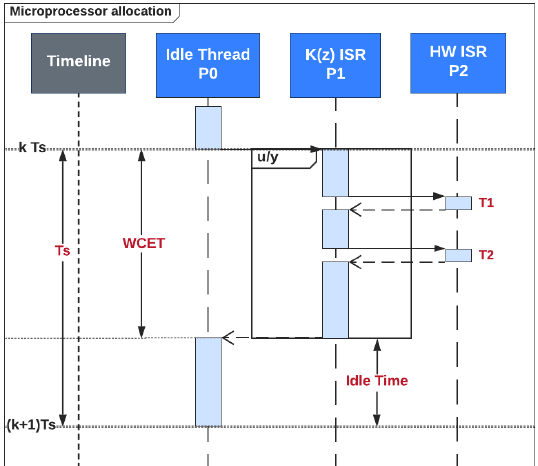
Figure 4. Sequence diagram illustrating the regulator K ( z ) interrupt service routine execution among higher and lower priority threads for the duration of one sampling period T s